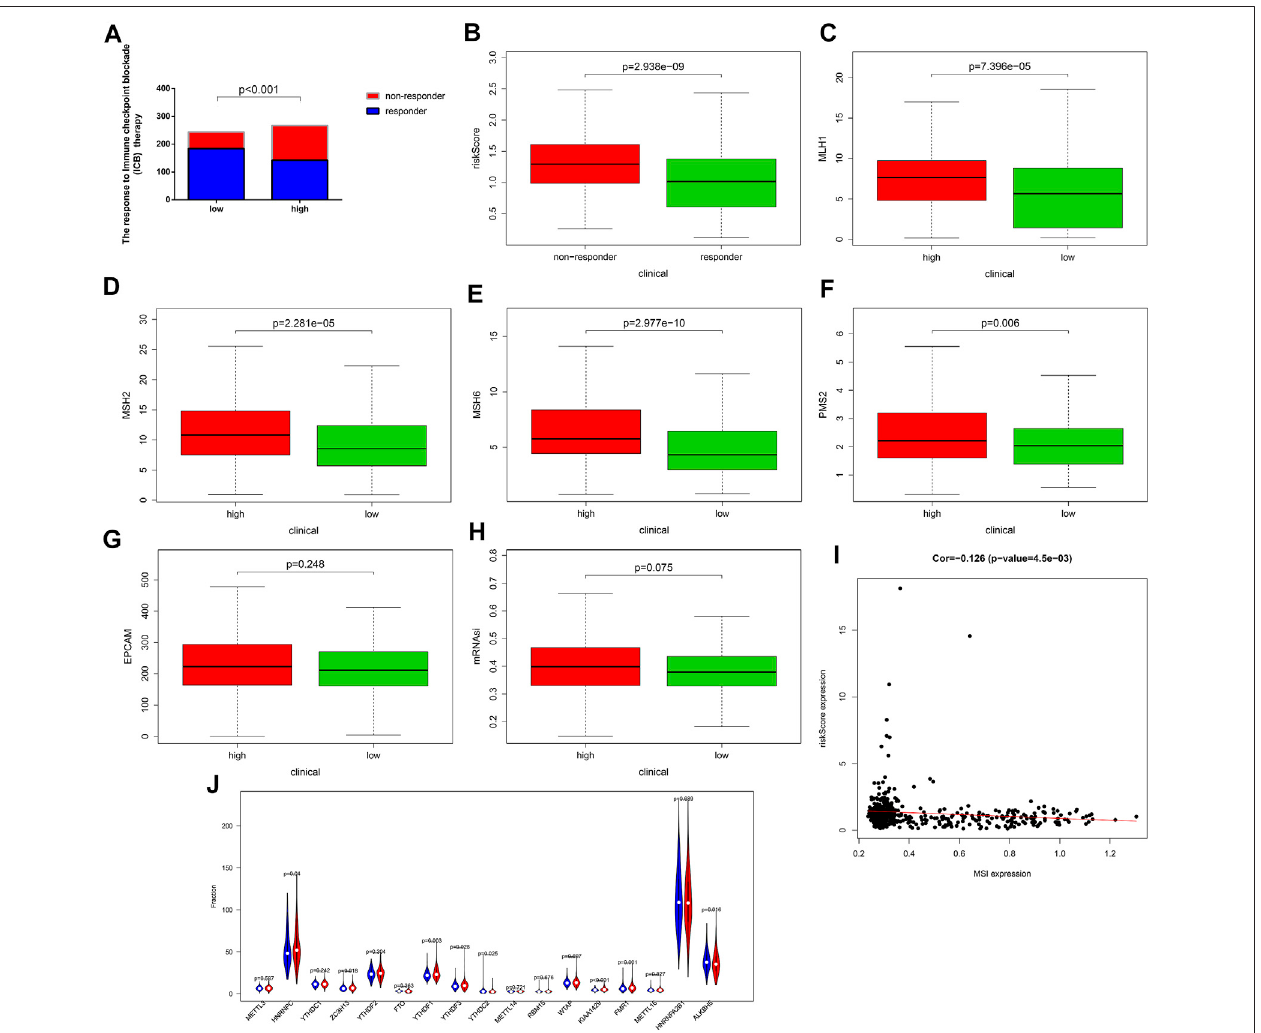
FIGURE8| Theresponsetoimmunecheckpointblockade(ICB)therapyandthemicrosatelliteinstability(MSI)statusofdifferentriskgroups. (A) Comparisonofthe response to immune checkpoint blockade (ICB) therapy between the low- and the high-risk groups. Patients in the low-risk group showed more sensitive response to ICB therapy than those in the high-risk group. (B – G) Patients in the low-risk group had lower expression of the dominant mismatch repair (MMR) proteins including MLH1,MSH2,MSH6,PMS2,andEPCAMthanpatientsinthehigh-riskgroup. (H) ThemRNAsiofthelow-riskgroupislowerthanthatofthehigh-riskgroup. (I) The correlationbetweentheMSIexpressionandtheriskscore. (J) Theexpressionofthemarkersofm 6 AmRNAmethylationregulatorsinthehigh-andlow-riskgroups.m 6 A, N 6 -methyladenosine. In the high-risk group, N (cid:1) 267; in the low-risk group, N (cid:1) 244.